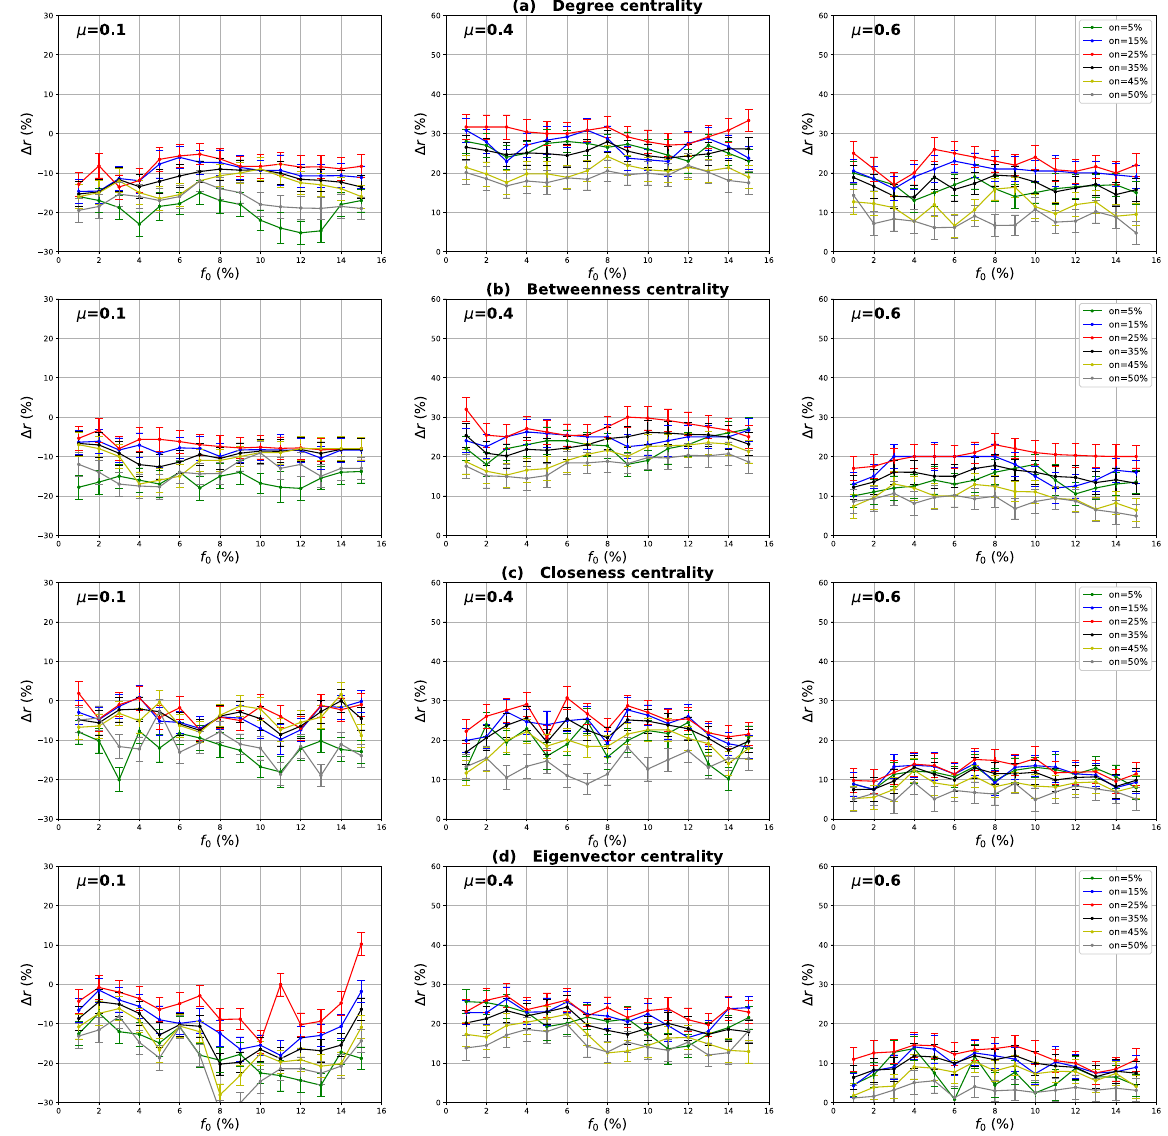
Figure 5. Influence of the number of overlapping nodes. The relative difference of the outbreak size Δ r between the standard measure and the Global measure versus the percentage of initial spreaders f 0 . The community membership value om is equal to 10% of the total number of